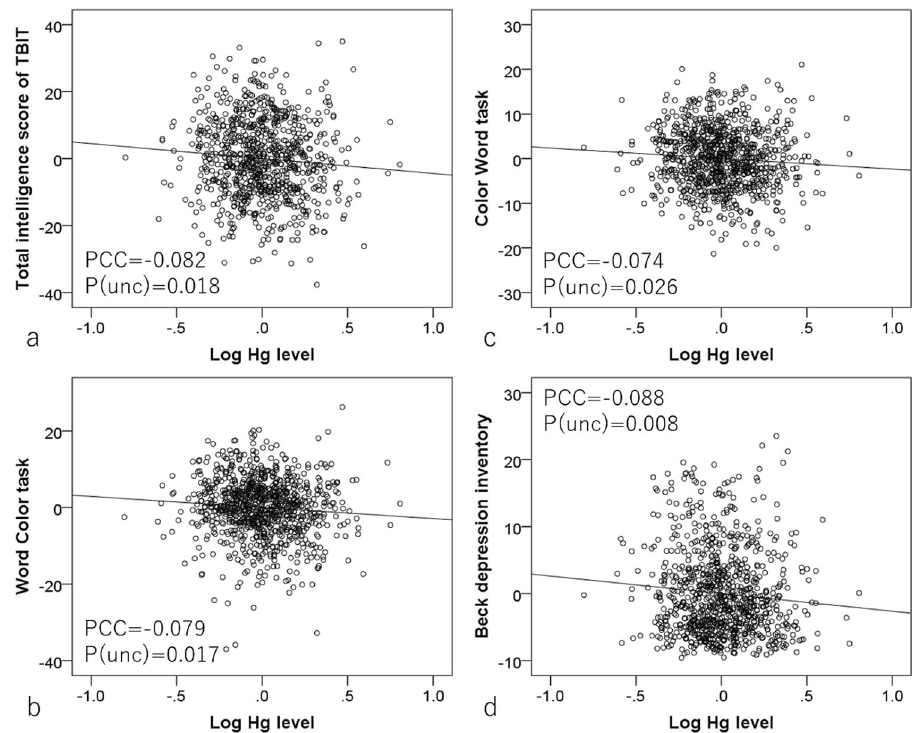
Fig. 1 Associations between hair mercury levels and psychological variables. Partial residual plots with the trend lines depicting the associations between residuals of psychological variables and residuals of the logarithms of hair mercury levels with other confounding factors controlled. PCC indicates partial correlation coef fi cients. Greater hair mercury levels (log values) were signi fi cantly associated with ( a ) lower total intelligence score on the TBIT, ( b ) lower performance on the Word-Color task, ( c ) lower performance on the Color-Word task, and ( d ) lower score on the Beck depression inventory.